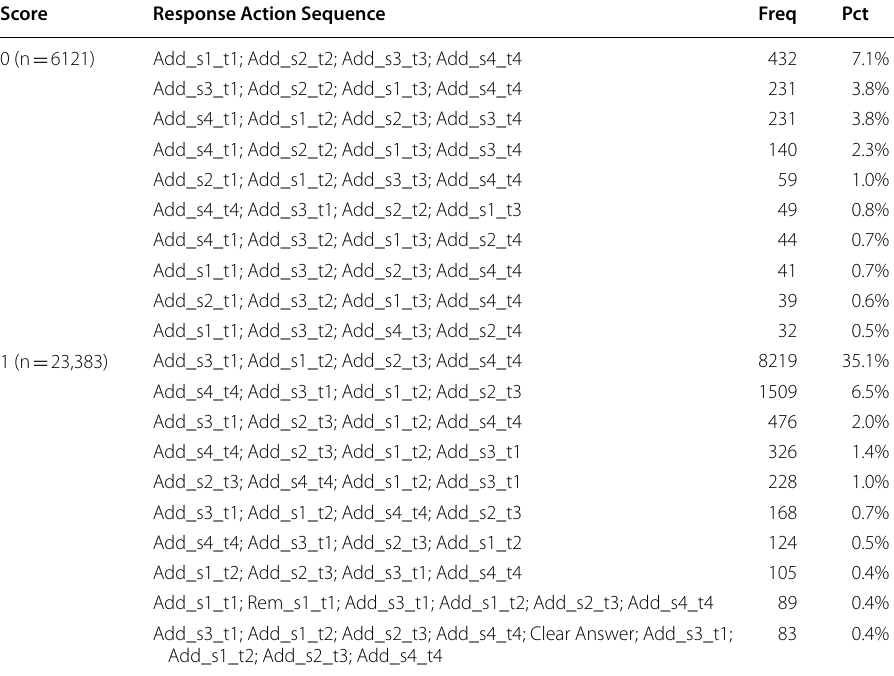
different scores on the G8 item and their frequency and proportion within each score